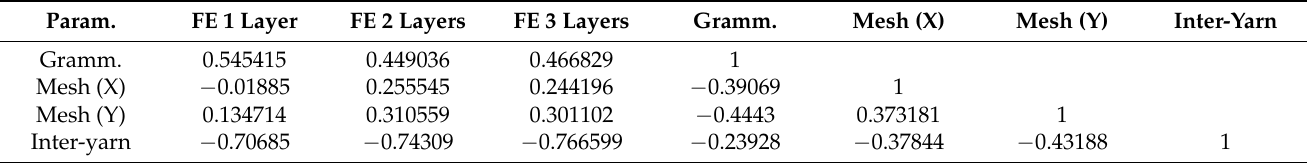
Table 3. Correlation between different material parameters.